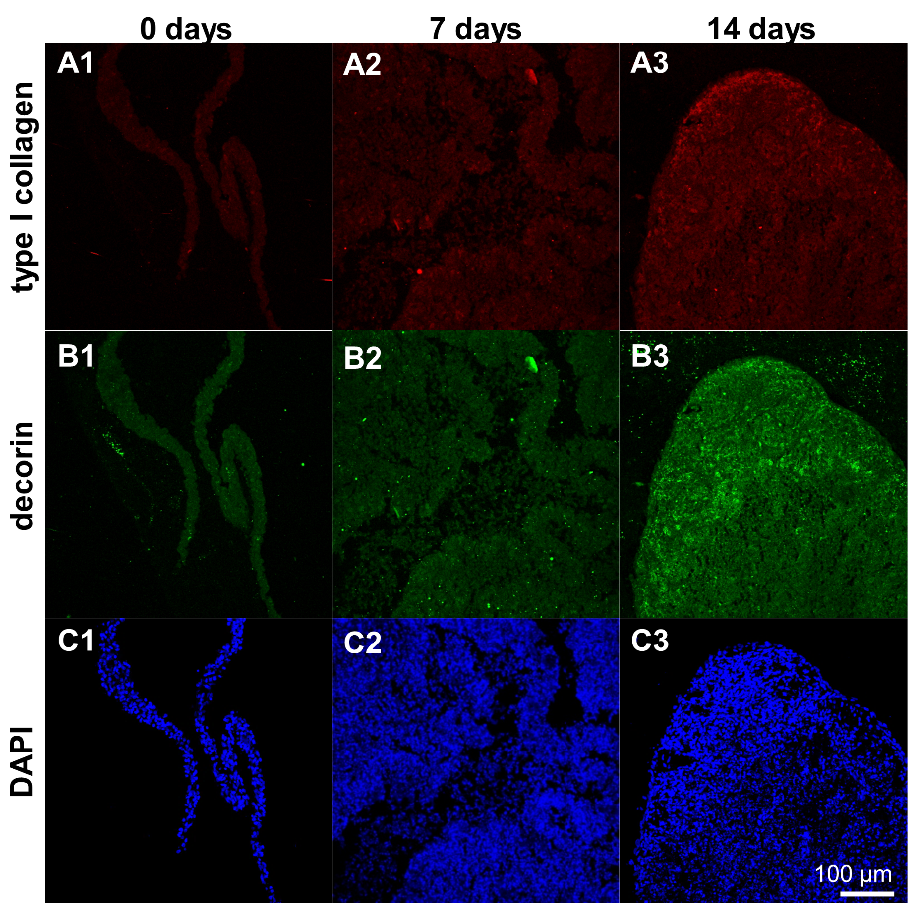
Figure 8. Protein expression of type I collagen and decorin by ligamentocyte sheets released from PGE-coated surfaces after detachment (0 d) and when cultured for 7 or 14 d. Type I collagen is depicted in red ( A1 – A3 ), decorin in green ( B1 – B3 ). Ligamentocyte nuclei were counterstained in blue using 4’,6-diamidino-2-phenylindole (DAPI) ( C1 – C3 ). A view on the sheet is shown by confocal laser scanning microscopy. Scale bar: 100 µm ( A1 – C3 ).